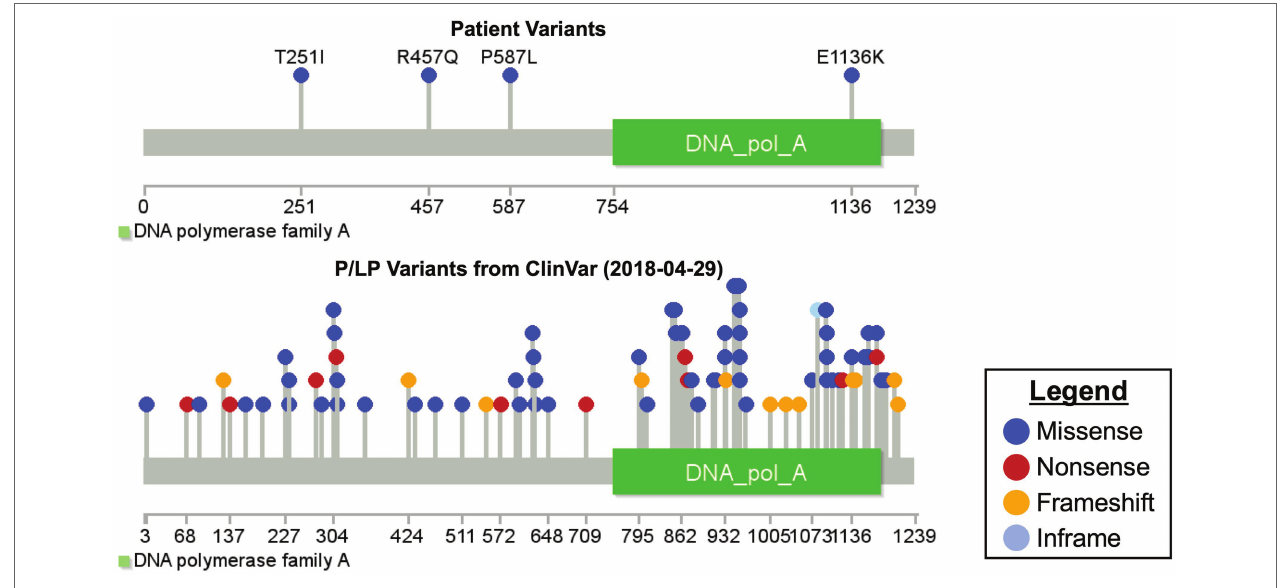
FIGURE 2 | Mutation diagram of polymerase